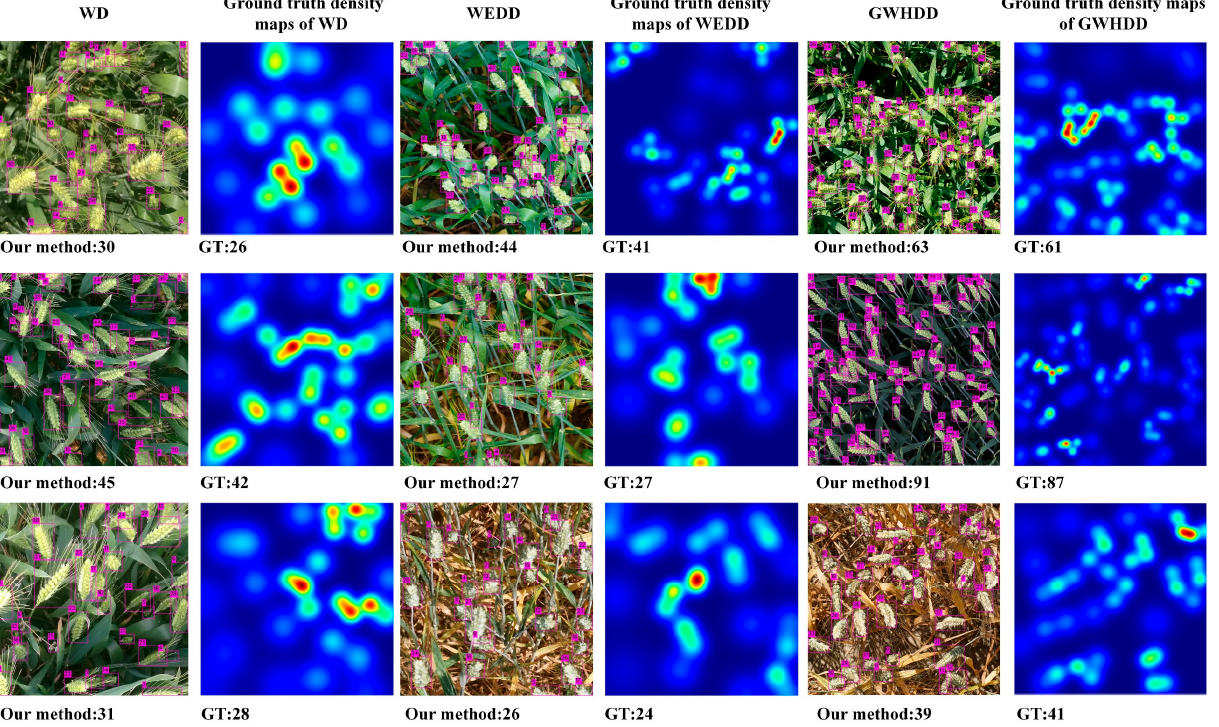
Figure 9. The comparison between the ground truth and the counting with our method. GT: ground truth.